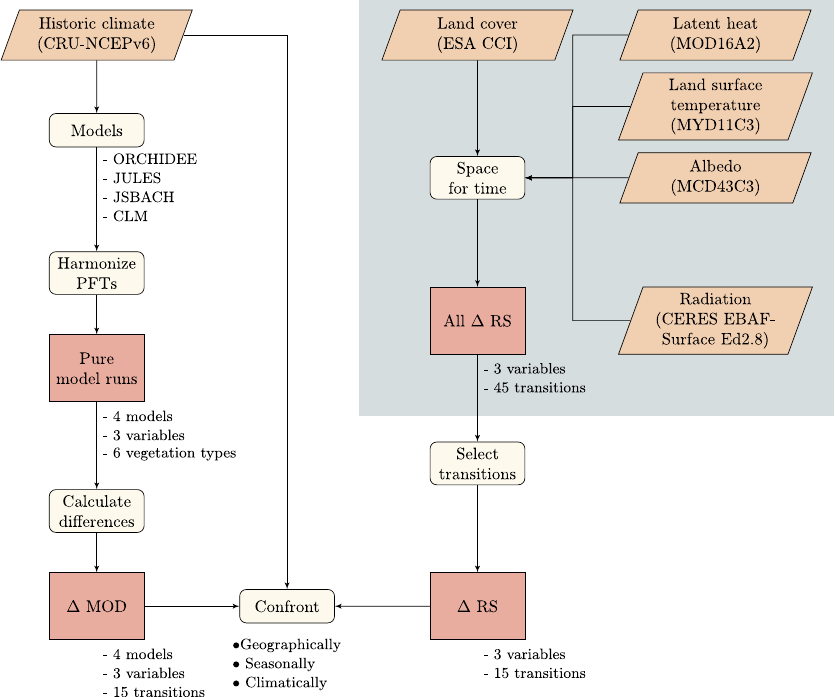
Figure 1. Flowchart resuming the processing steps undertaken for the present study. The part in the grey box corresponds to work done in a previous study (Duveiller et al.,